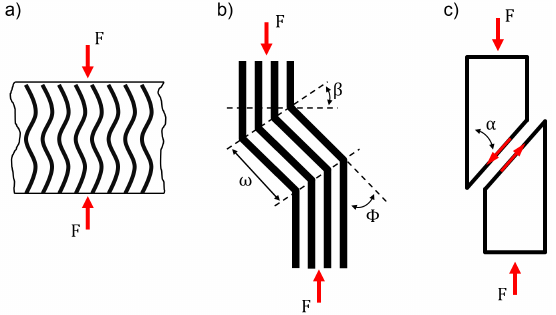
Figure 1. Scheme showing the different mechanisms contributing to compressive failure of FRP: ( a ) in-phase microbuckling; ( b ) kink-band geometry; ( c ) shear